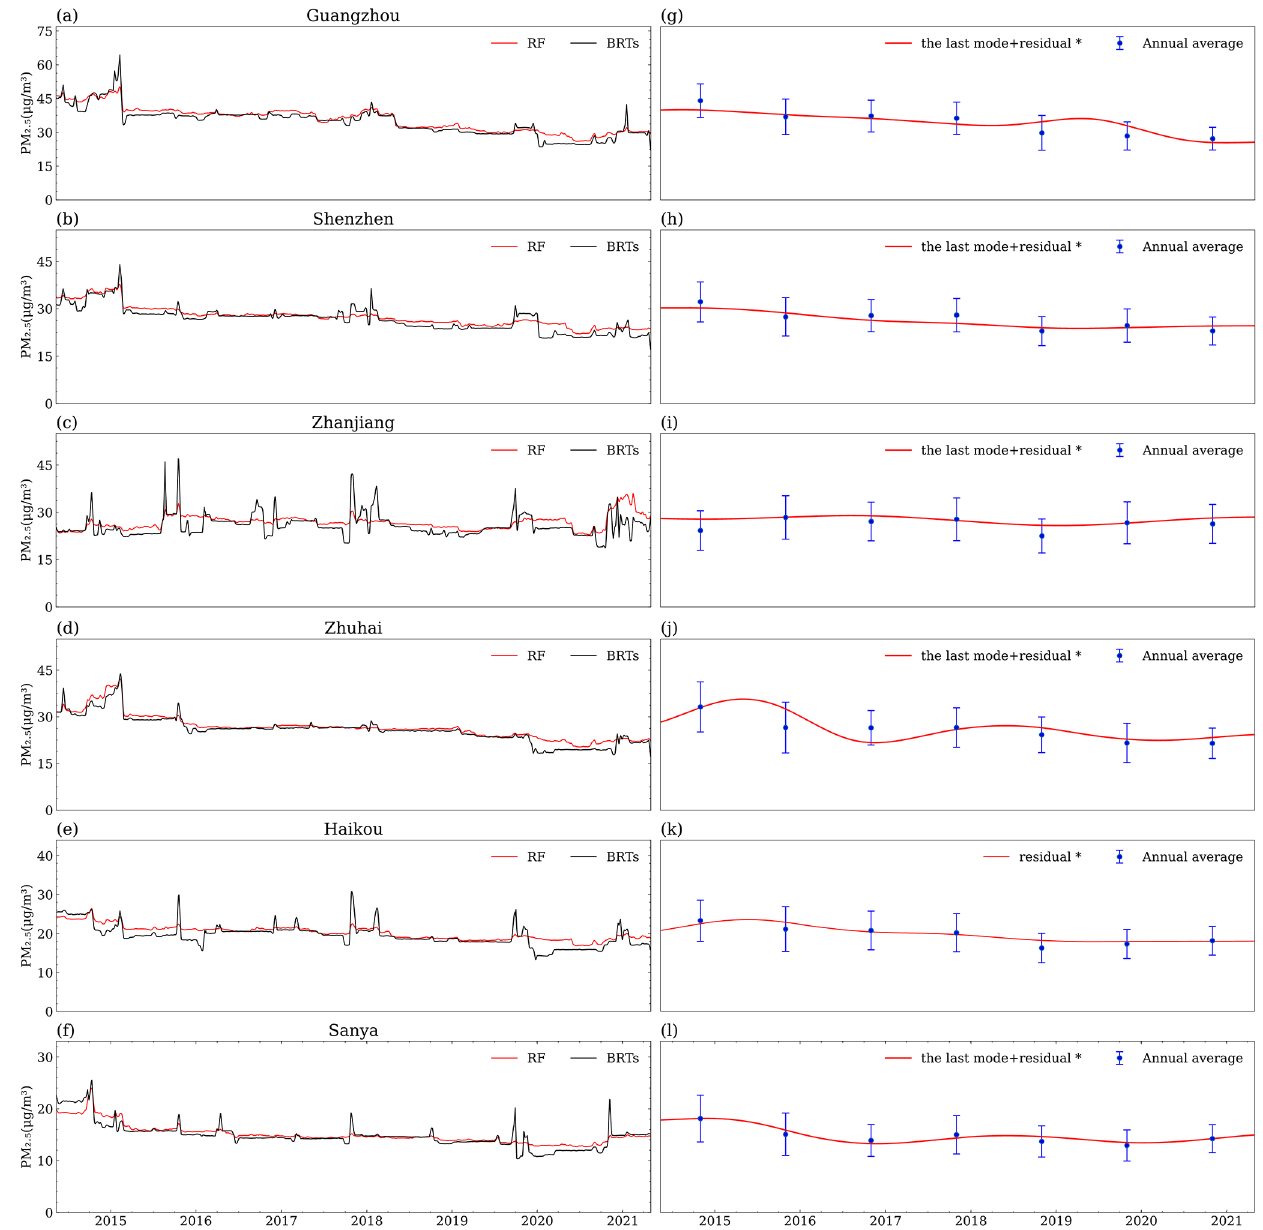
Figure 4. The RF-deweathered and BRT-deweathered concentrations and ICEEMDAN-decomposed residuals (or mode + residuals) of PM 2 . 5 and annual averages from May 2014 to April 2021. (a–f) Deweathered concentrations in the six cities (the order of the cities is the same as that listed in Table 1); (g–l) decomposed residual or the last mode + residual and annual averages plus one-third standard deviation in the six cities ( ∗ represents the time series of values to be used to calculate the trend and